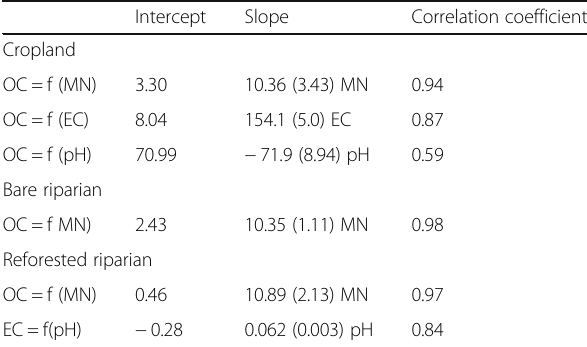
Table 5 The summary for the simple linear correlation analysis performed to determine whether the interactions between the different soil attributes under a given land-use practice are significant. The depth increment in the analysis was a selection